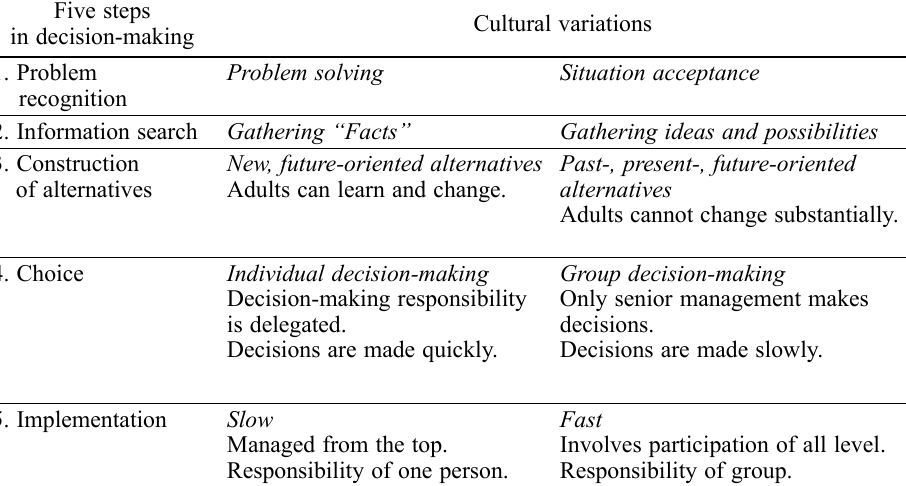
Table 3. The cultural contingencies of